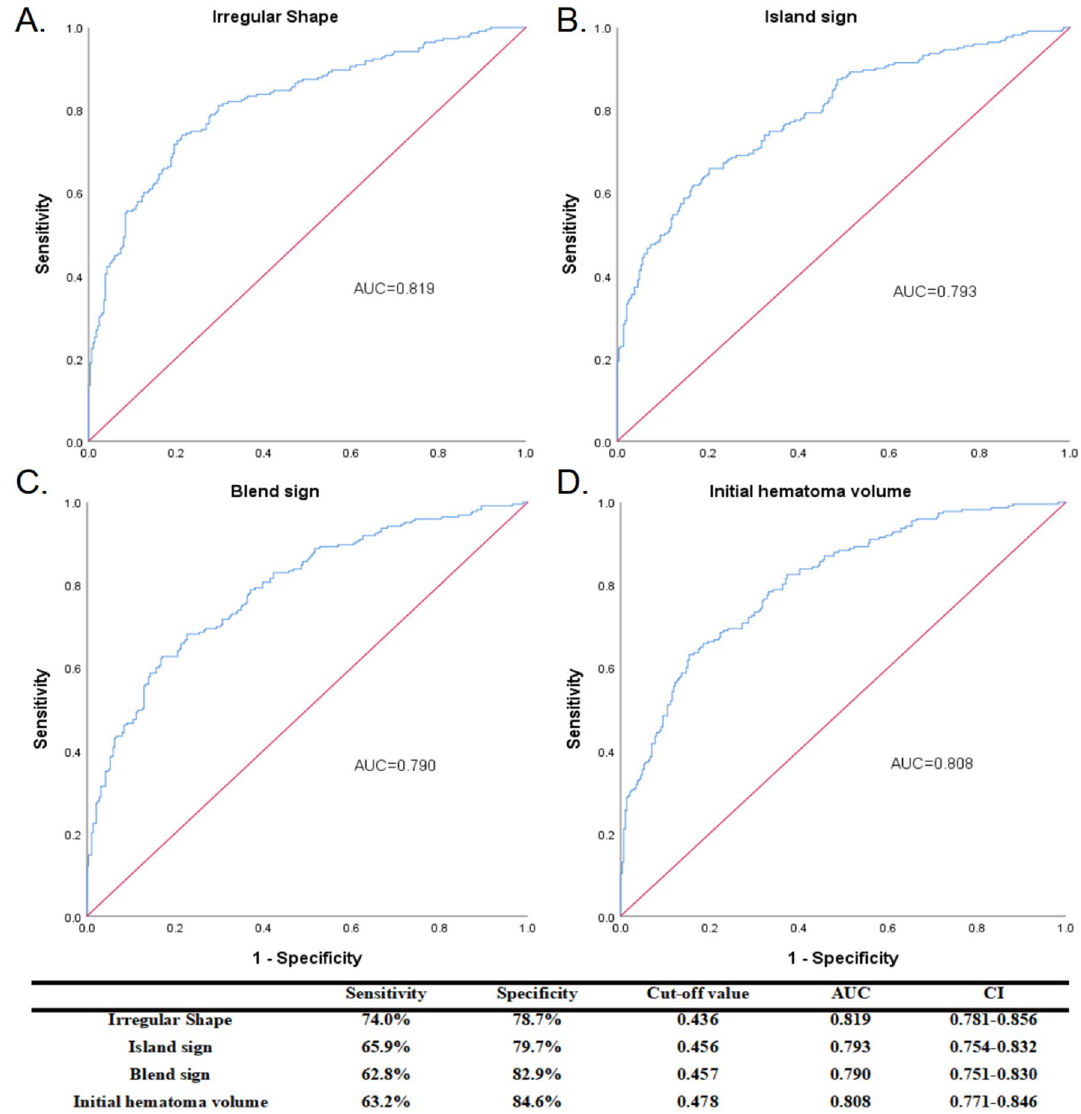
identified with their sensitivity, specificity, and confidence interval (CI),